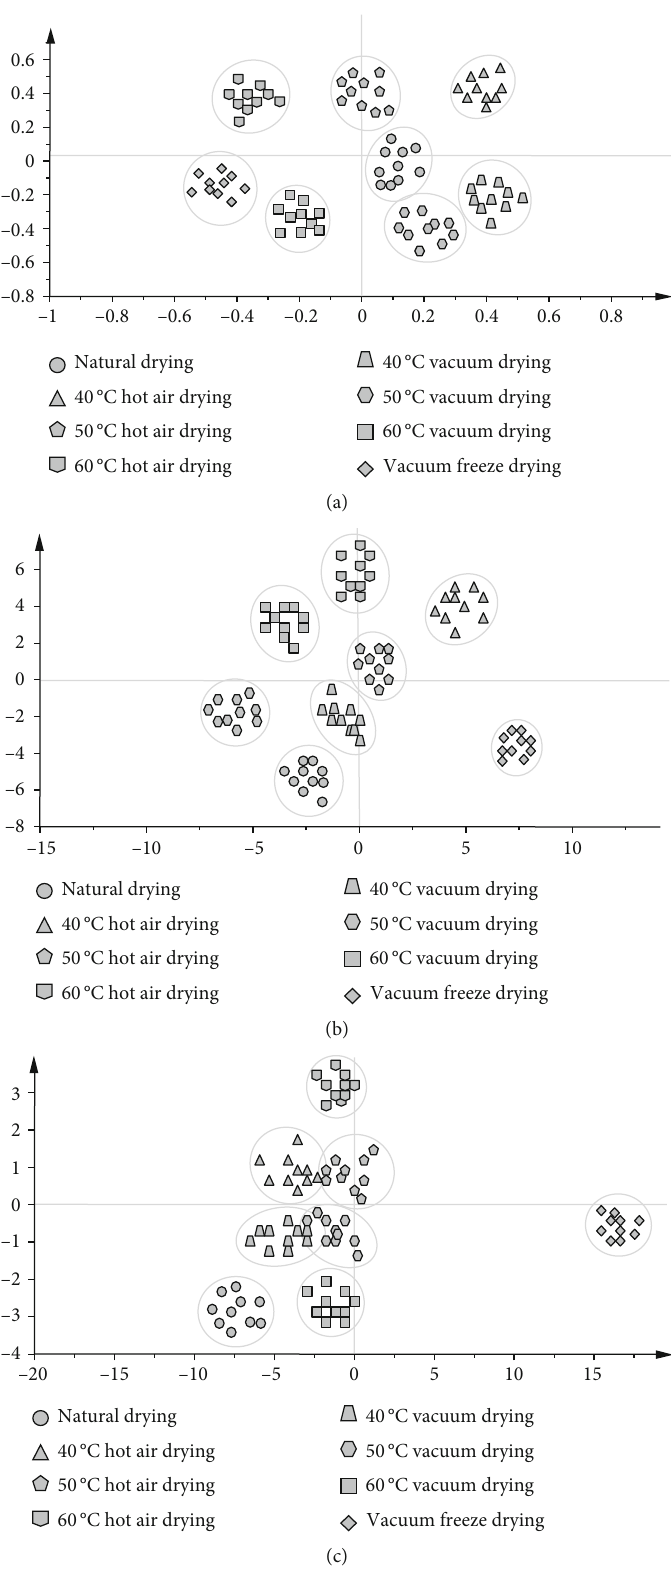
Figure 2: PLS-DA scores plot of (a) lignans, (b) organic acids, and (c)